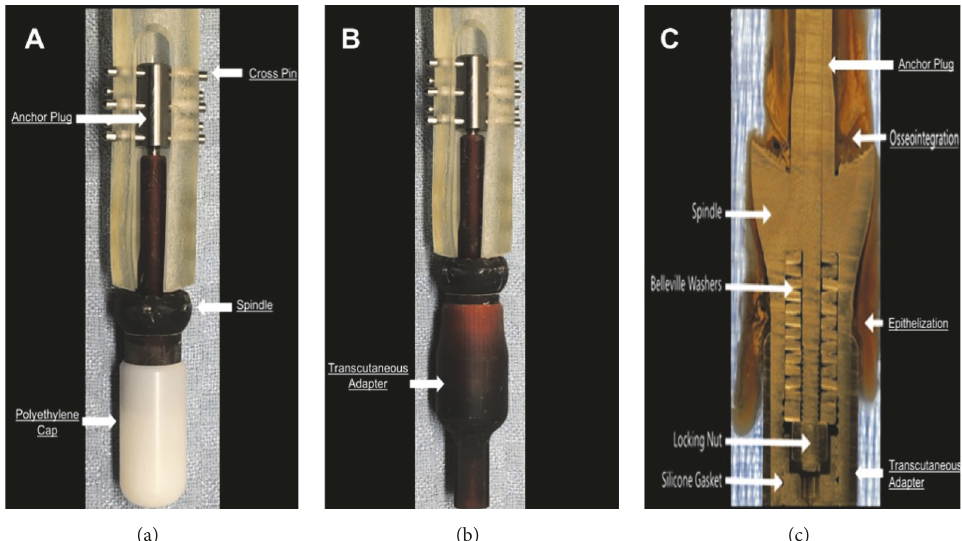
Figure 1: (a) During the first procedure, the spindle and anchor plug are implanted. A cap is placed over the spindle and the soft tissues are closed to allow for provisional healing. (b) The cap is removed at the second surgery and the taper fit transcutaneous adapter is applied. (c) A cross section of the implant demonstrating the compression mechanism. Compression of the spindle against the bone is generated by tightening of the anchor plug locking nut against the Belleville washers. The anchor plug is secured proximally by cross pins (not shown). A silicone gasket fits within the distal end of the spindle to deter bacterial migration proximally into the canal. The taper fit transcutaneous adapter is attached over the distal aspect of the spindle.